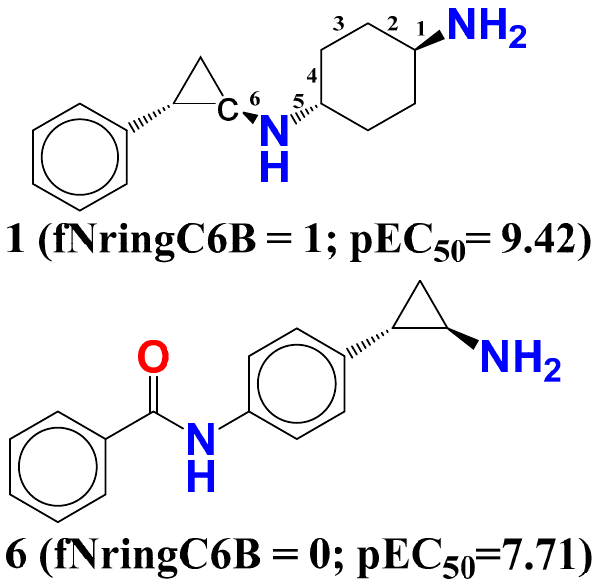
( lipo_ringS_8Bc = 0; pEC 50 = 6.917), 35 ( lipo_ringS_8Bc = 0; pEC 50 = 6.827) with 36 ( lipo_ringS_8Bc = − 0.28; pEC 50 = 6.81), and 45 ( lipo_ringS_8Bc = − 0.207; pEC 50 = 6.511) with 46 ( lipo_ringS_8Bc = − 0.231; pEC 50 = 6.509). Figure 4. Illustration of molecular descriptor fNringC6B for the molecules 1 and 6 only. This observation was also seen by comparing the subsequent pair of molecules: 17( P IC 50 = 7.25, fNringC6B = 2) with 18( P IC 50 = 7.21, fNringC6B = 0), 31( P IC 50 = 7.04, fNringC6B = 4) with 32( P IC 50 = 6.91, fNringC6B = 0), 52( P IC 50 = 6.11, fNringC6B = 1) with 56( P IC 50 = 5.88, fNringC6B = 0), etc.